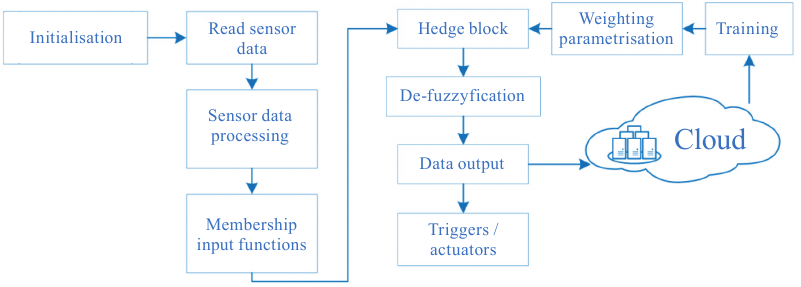
Figure 6. Fuzzy logic block diagram of agent and cloud interaction